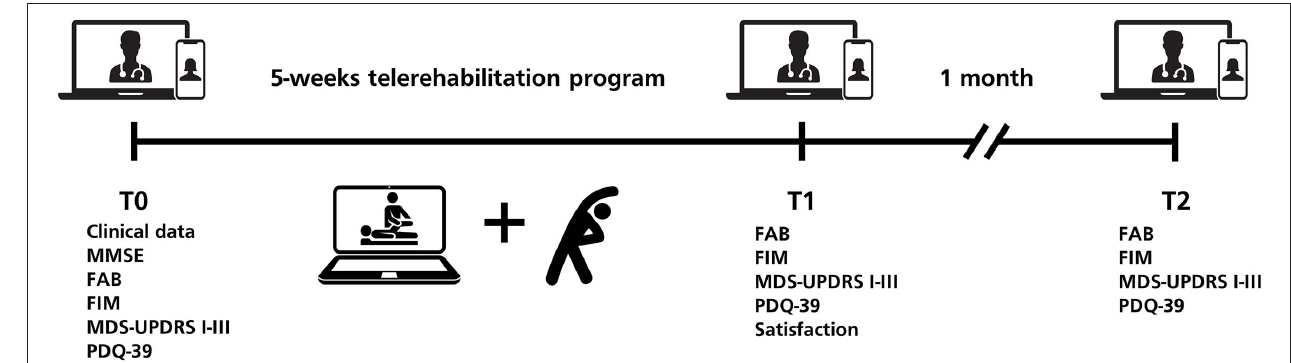
FIGURE 1 | Study design.